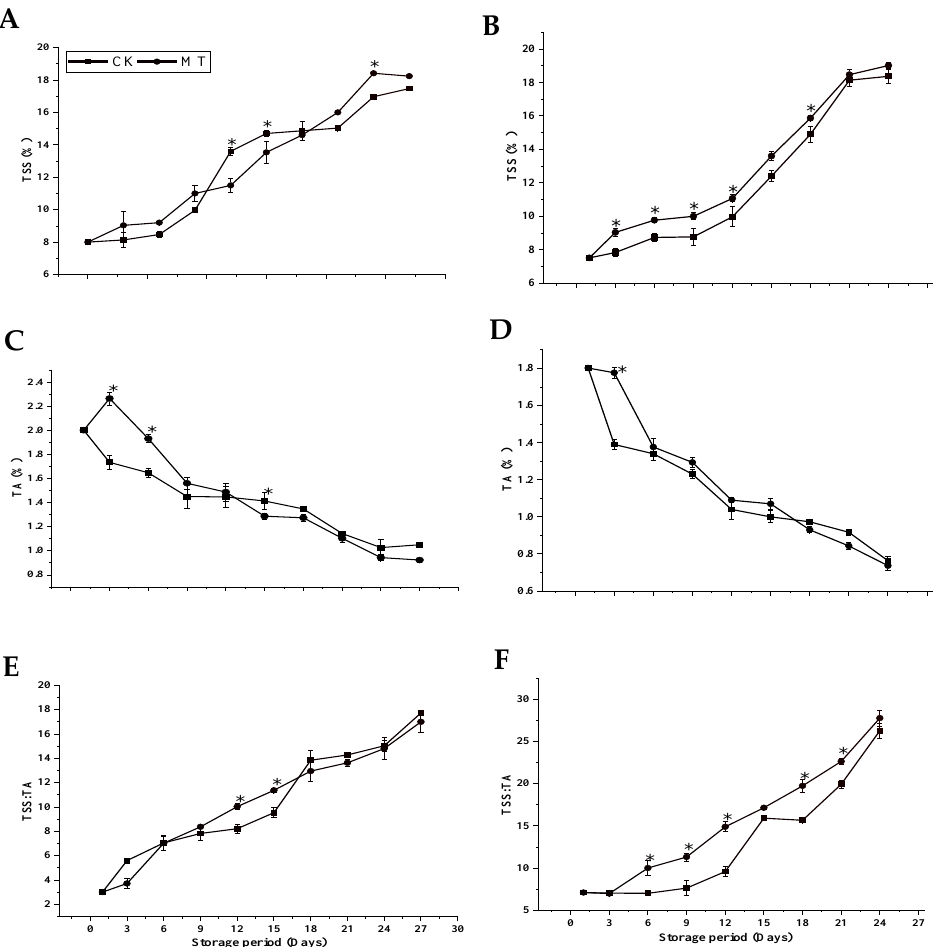
Figure 3. TSS ( A , B ), TA ( C , D ), and TSS:TA ratio ( E , F ) of ‘Guiqi’ ( A , C , E ) and ‘Tainong 1’ ( B , D , F ) fruits treated with 1000 μmol L −1 MT. Each value is the mean for three replicates, and vertical bars indicate the standard error (SE). Error bars with an asterisk (*) on the same storage period show a significant difference between the treatments ( p < 0.05).